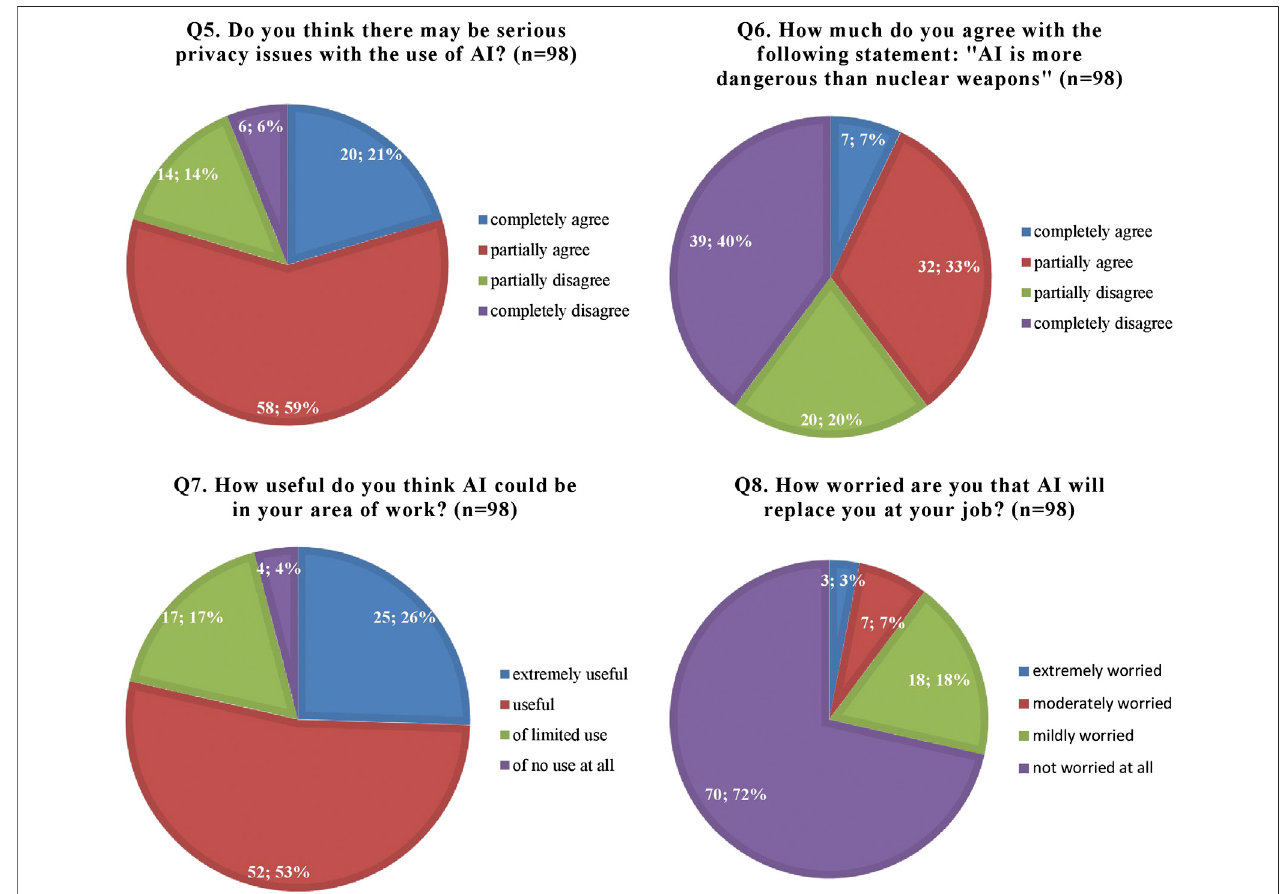
FIGURE 2 | Participants ’ attitudes and worries regarding arti fi cial intelligence (AI) and its applications.